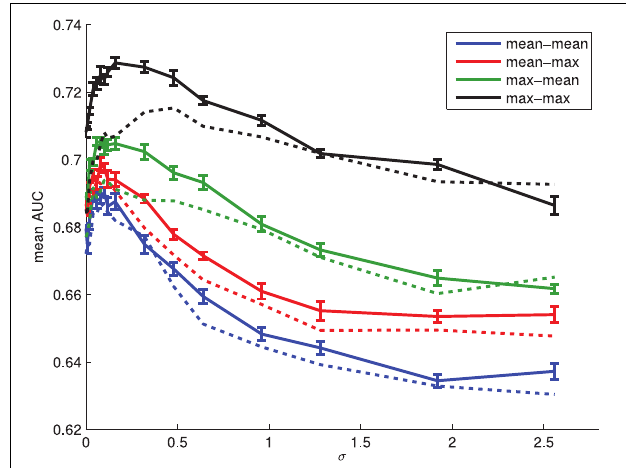
FIGURE 3 | The ability of attentional landscape scores to predict the objects an individual will name for a range of σ values (expressed in degrees of visual angle). Scores were obtained by first taking the maximum or mean of pixels within objects, and then aggregating over objects belonging to a class, again using the maximum or mean. In the legend above, mean-max means object scores were calculated as the maximum saliency over pixels within the object boundary, while label scores were defined as the mean over all objects associated with the object. Solid lines: attention landscape with weighting by fixation duration. Dashed lines: no weighting by fixation duration. Error bars show the standard error for the AUC scores obtained from the 10-fold cross validation.